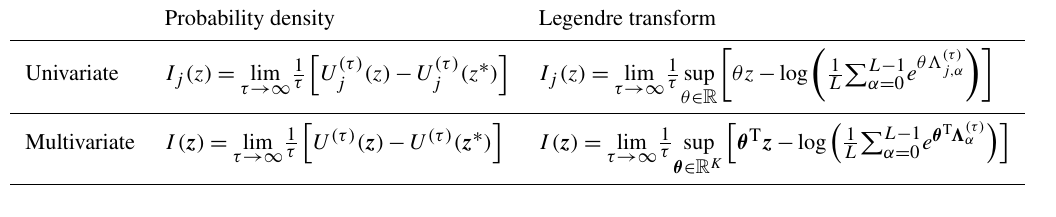
Table 5. Methods for estimating the diffusion matrix.